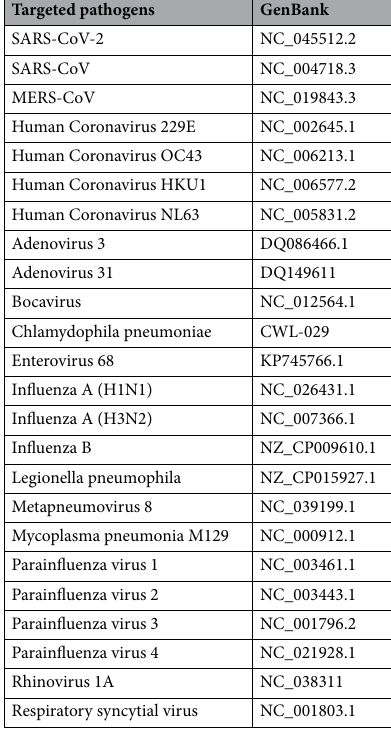
Table 2. In silico Cross-reactivity analysis of the SaliVISION multiplex primer set.